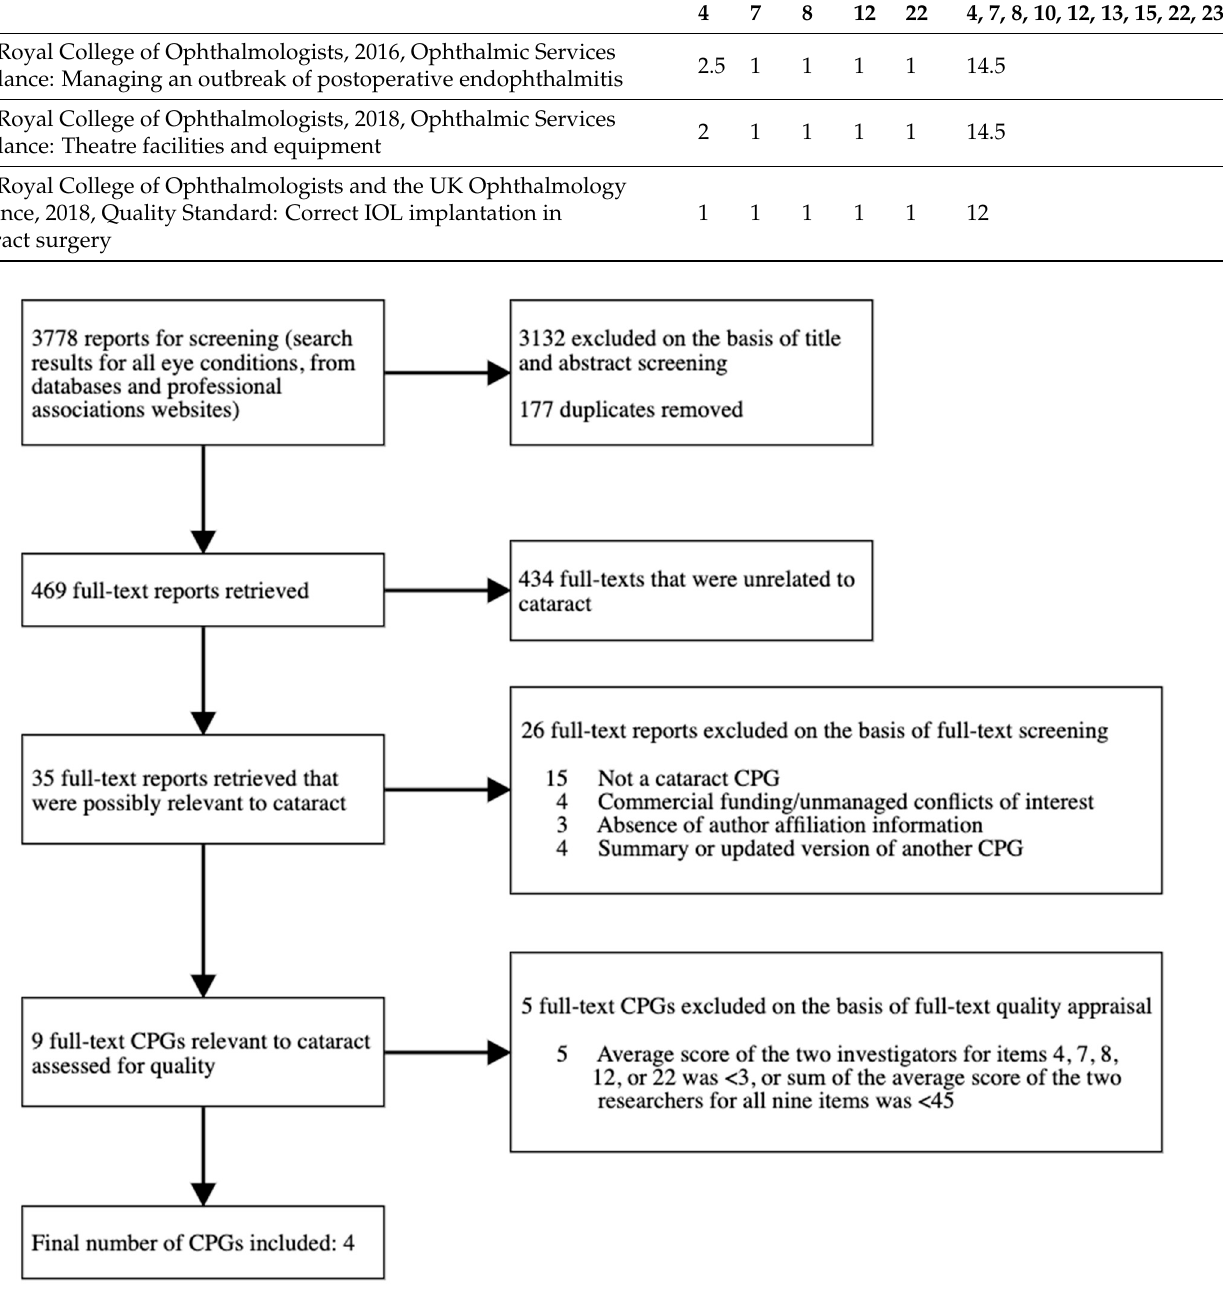
Figure 1. Flow chart of the screening process. Table 3. AGREE II scores for the Clinical Practice Guidelines (CPGs) that were selected for appraisal after full text screening.